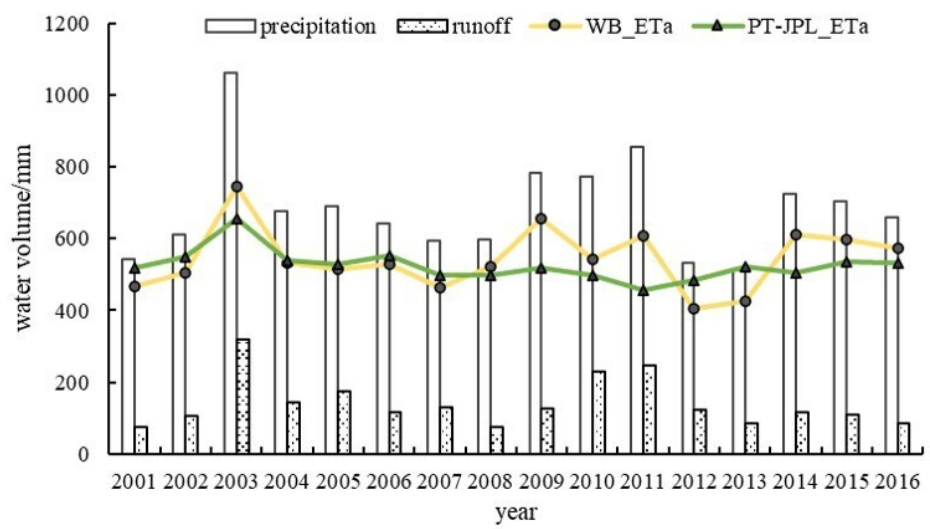
Figure 2. Comparison of precipitation, runoff depth, and evapotranspiration calculated by water balance and evapotranspiration calculated by the PT-JPL model from 2001 to 2016.